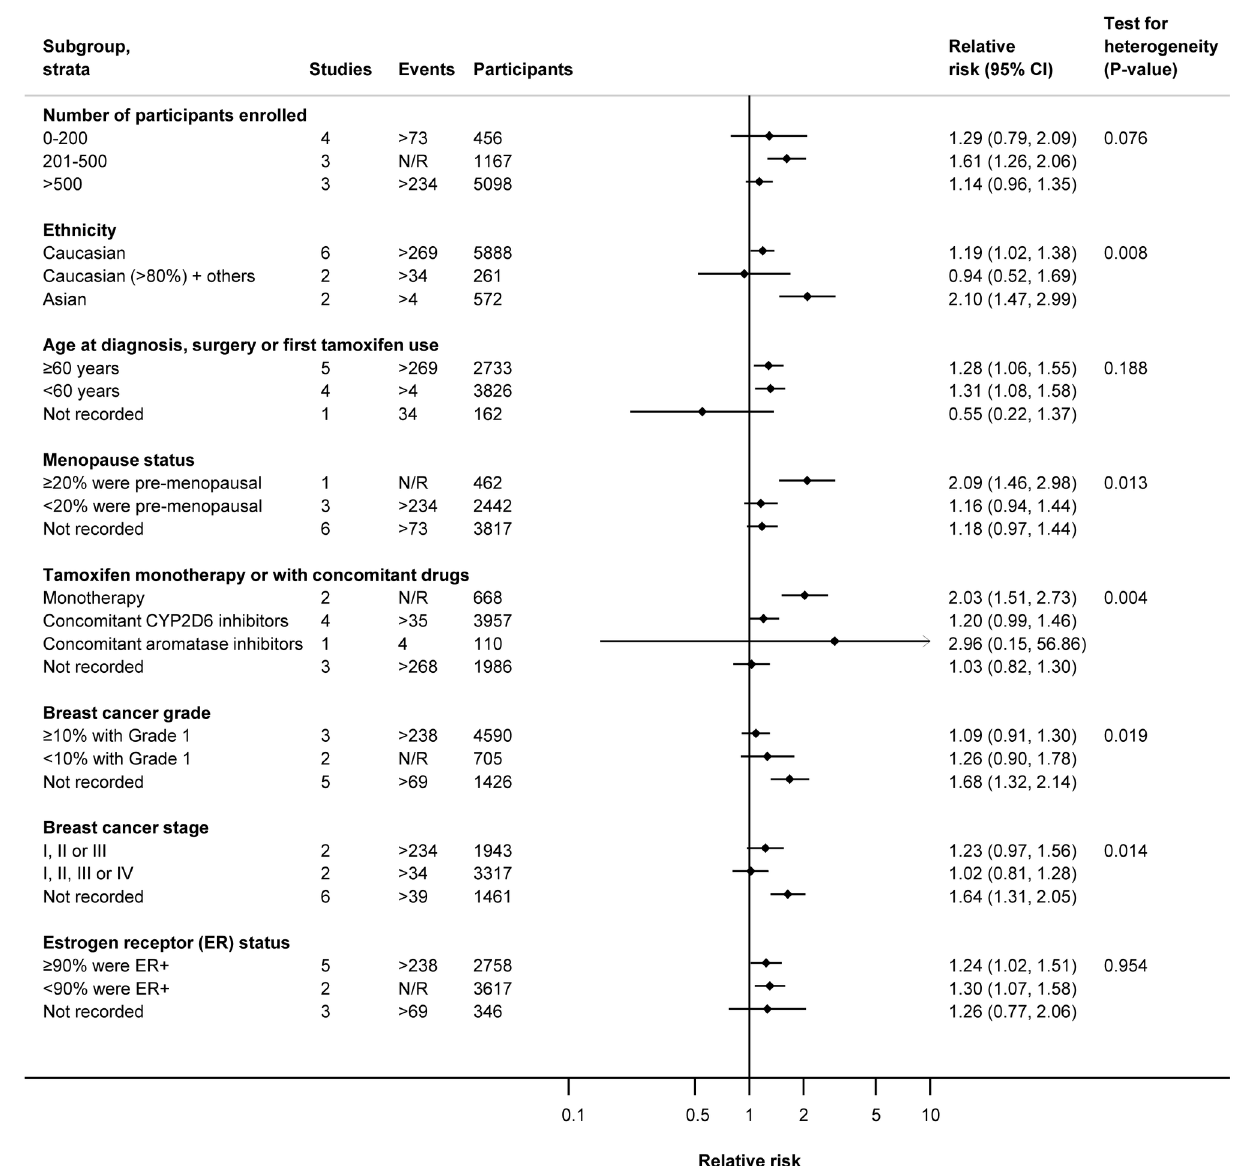
Figure 3. Subgroup analyses of the association between any reduced function CYP2D6 allele vs. none for the composite outcome of all-cause mortality and surrogate endpoints for overall survival (including non-fatal